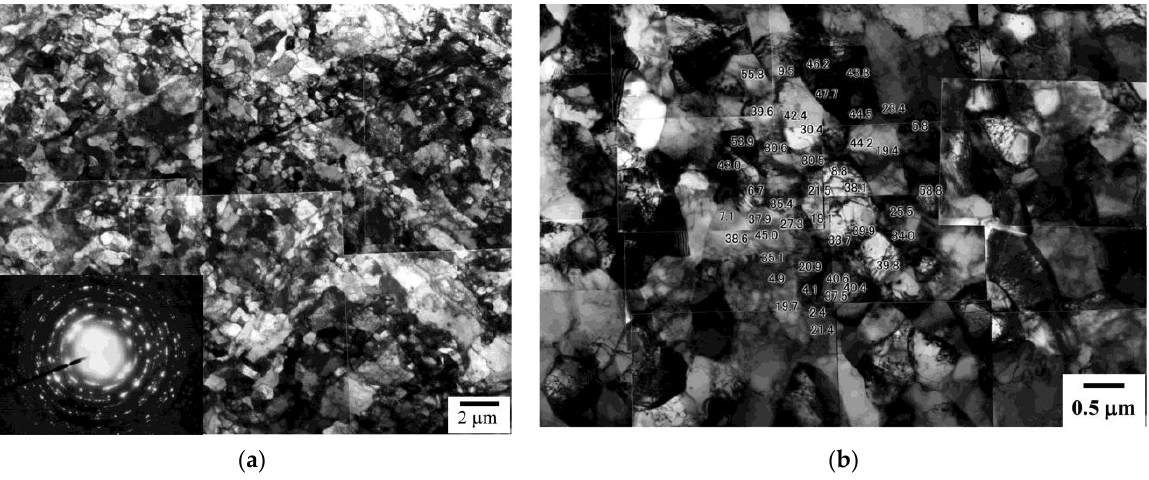
Figure 5. UFG microstructures in a Fe-20%Cr steel after multiple forging at 773 K to total strains of 3.6 ( a ) and 8.0 ( b ). Numbers in ( b ) indicate the boundary misorientations in degrees. Reproduced from [60], with permission from Springer Nature, 2023.